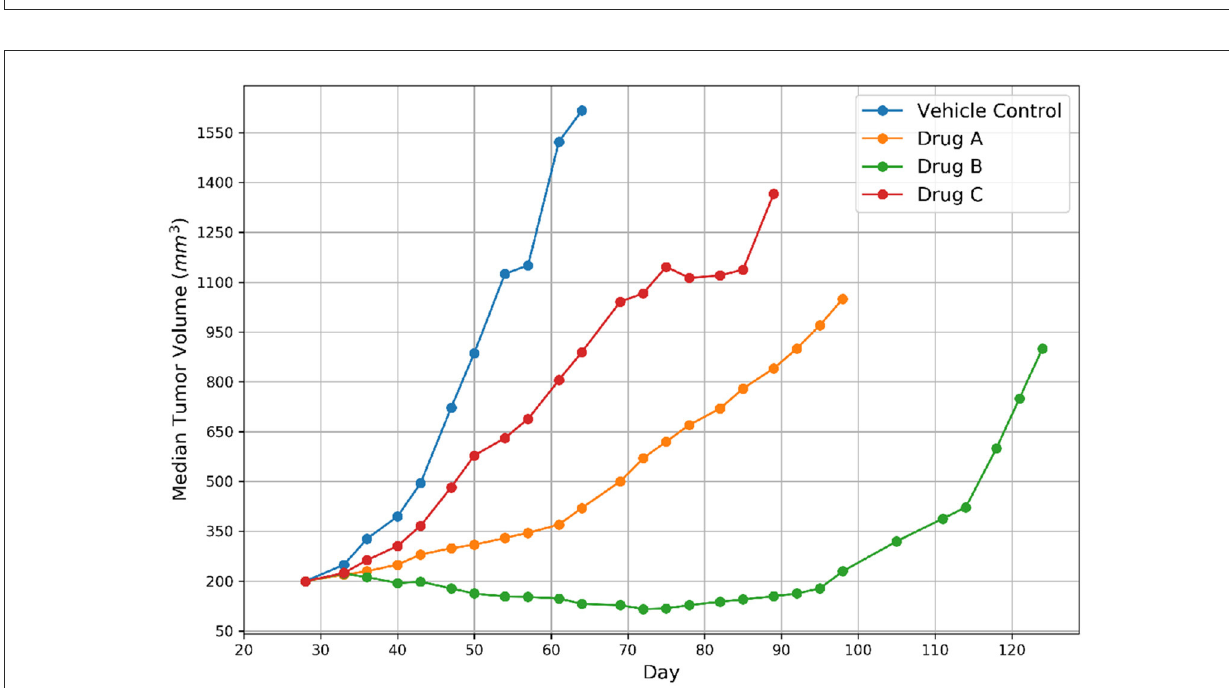
FIGURE2 Representative tumor growth curves for vehicle control and three drugs. The label of response was assigned to Drug B because the tumor achieved regression and non-response was assigned to the remaining drugs.